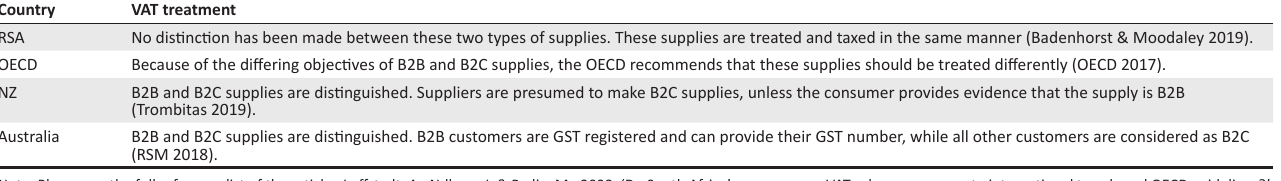
TABLE 4: A comparison of the value added treatment of business-to-business and business-to-consumer supplies in Republic of South Africa, Organisation for Economic Co-operation and Development guidelines, New Zealand and Australia.